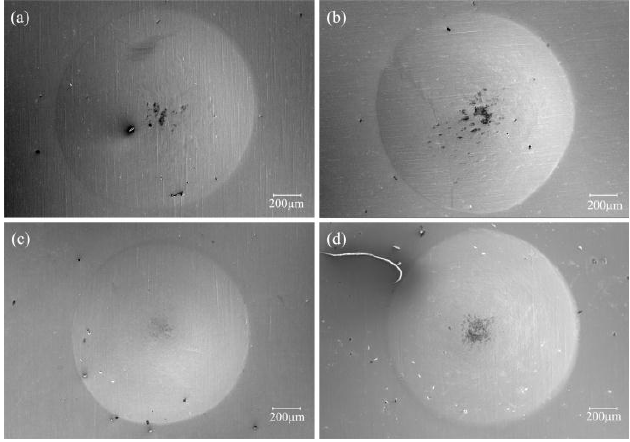
Figure 5. The surface morphology of micro bulging parts under different conditions: ( a ) 60 µm, 565 mJ ( b ) 60 µm, 835 mJ ( c ) 40 µm, 565 mJ ( d ) 40 µm, 835 mJ.